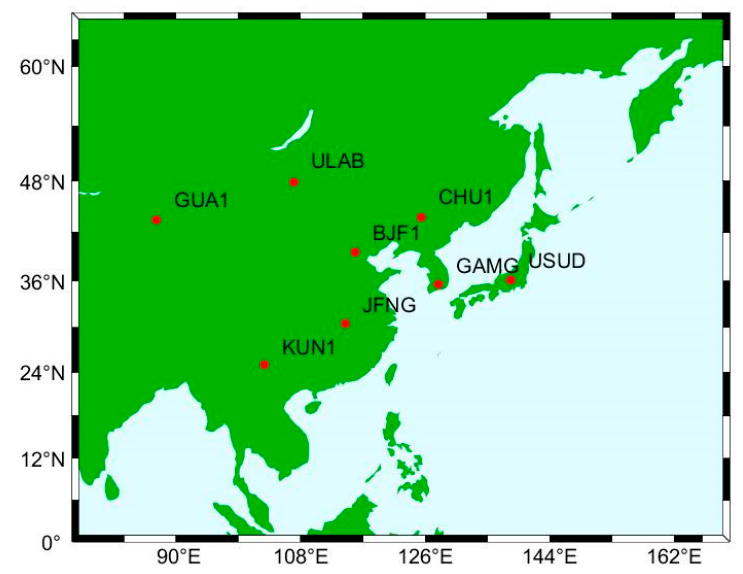
Figure 3. Distribution of the eight stations for experiments.